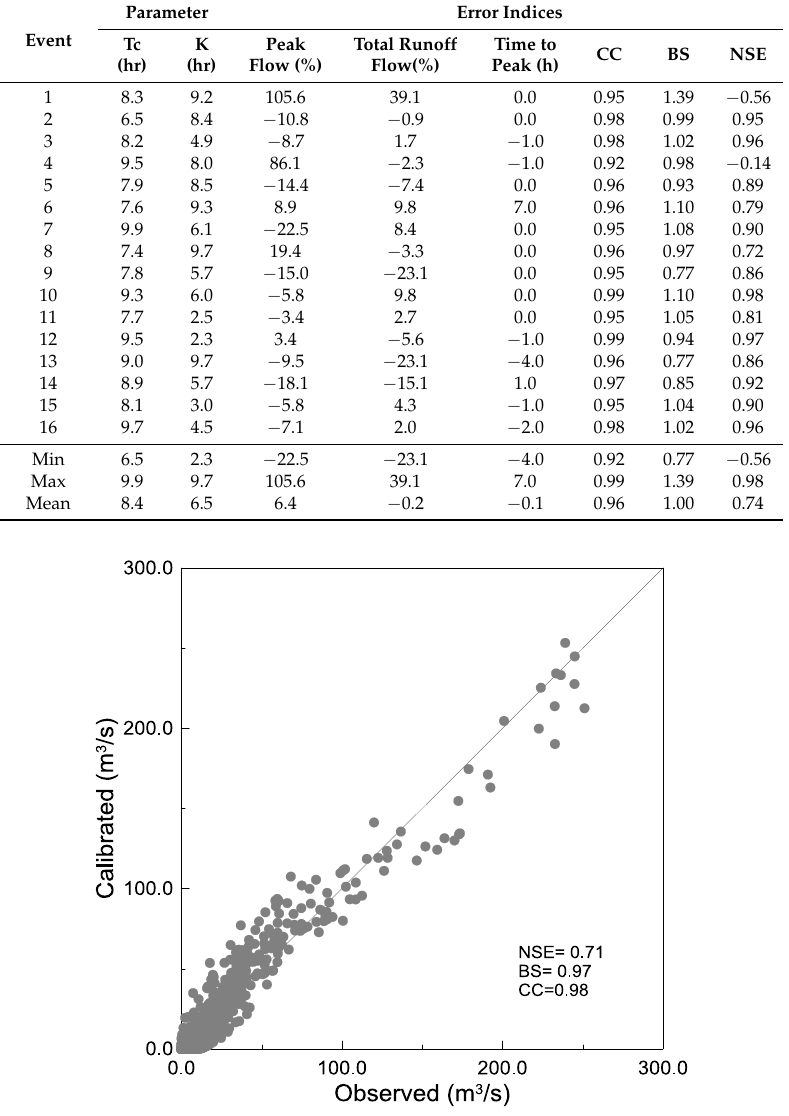
Table 4. Estimated results of parameters with error indices between the observed and simulated streamflows: In this table, Errors in peak flow and total runoff flow are calculated using the equation, error (%) = (cal. − obs.)/obs. × 100. Correlation coefficient (CC), bias (BS), and Nash-Sutcliffe efficiency coefficient (NSE) indicate correlation coefficient, bias (ratio), and Nash-Sutcliffe efficiency coefficient, respectively. Parameter Error Indices Event Tc K Peak Total Runoff Time to CC BS NSE (hr) (hr) Flow (%) Flow(%) Peak (h)